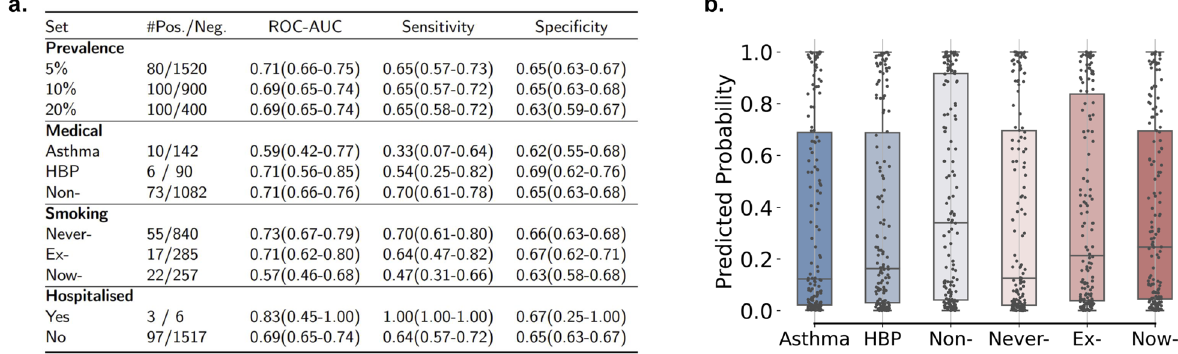
Fig. 3 Performance comparison under different conditions. a Performance for different prevalence levels, for participants with asthma/HBP or without any medical history, for never-, ex- and now-smoking participants, and for hospitalised and non-hospitalised participants. # denotes the number of positive/negative participants. b Predicted probabilities of infecting COVID-19 on those negative participants, with values above 0.5 indicating a false positive. No signi fi cant difference was observed across